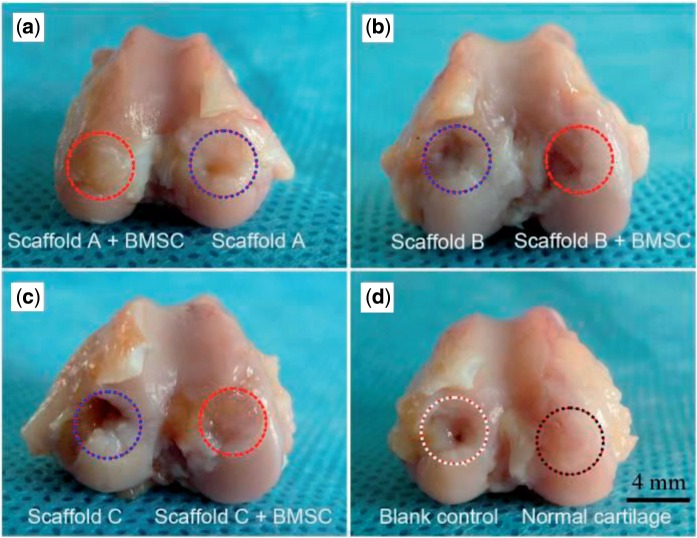
Gross views of regenerative tissues 12 weeks after implantation. Both medial and lateral condyles of knee joints of New Zealand white rabbits were drilled and then repaired by implanting PLGA scaffolds with or without external BMSCs. The blank control refers to neither scaffold nor external cells; the group of ‘normal’ means re-implantation of autologous osteochondral plug.